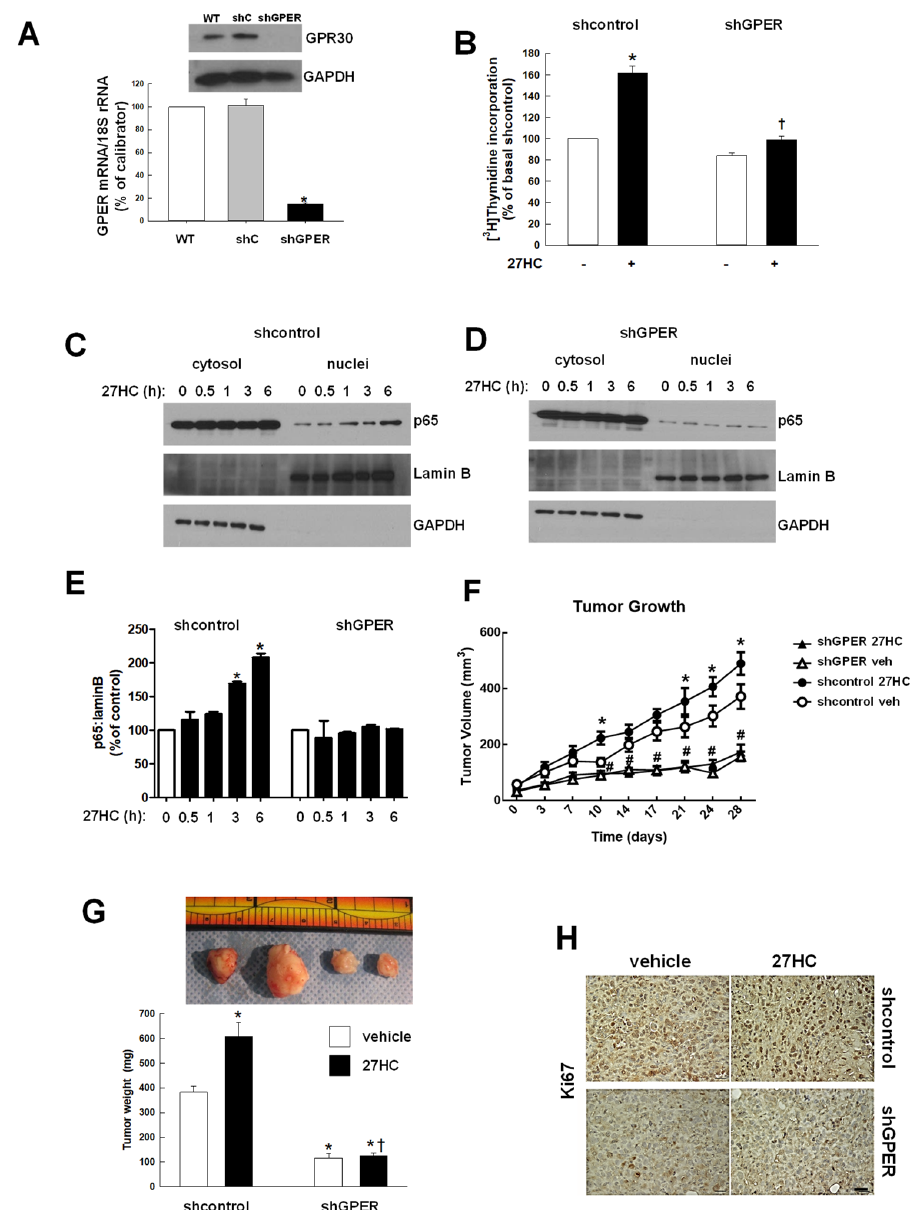
Figure 4. GPR30 mediates 27HC effects in ER − breast cancer cells. ( A ). GPER expression in parental (WT), shcontrol (shC) and stably GPER-silenced (shGPER) MDA-MB-231 cells were evaluated by Western blot analysis on whole-cell lysates (upper inset) and by real-time QPCR (lower graph). ( B ). Cells were left untreated ( − ) or treated (+) for 48h with 27HC (10 − 6 M) and proliferation was evaluated by 3 H-thymidine incorporation. ( C – E ) ShC and shGPER MDA-MB-231 cells were treated with 27HC (10 − 6 M) for 0–6 h, cytosolic and nuclear fractions were obtained, and Western blotting was performed for p65, Lamin B and GAPDH. Representative immunoblots are shown in ( C , D ), and quantitative summary data are shown in ( E ). Values are mean ± SEM, n = 5, * p < 0.05 vs. control (0) . ( F , G ) Xenografts were initiated by implanting either shcontrol or shGPER MDA-MB-231 cells into the mammary fat pads of SCID mice. ( F ) . Growth curves of tumors were measured by caliper. * p < 0.05 vs. shcontrol vehicle, # p < 0.05 vs. shcontrol 27HC. ( G ) Representative tumors and final tumor weights. Values are mean ± SEM, n = 7, * p < 0.05 vs. shcontrol vehicle, † p < 0.05 vs. shcontrol 27HC. ( H ) Ki67 abundance was evaluated in tumors by immunostaining. Primary images were obtained with a 20 × objective, scale bar 25 µ